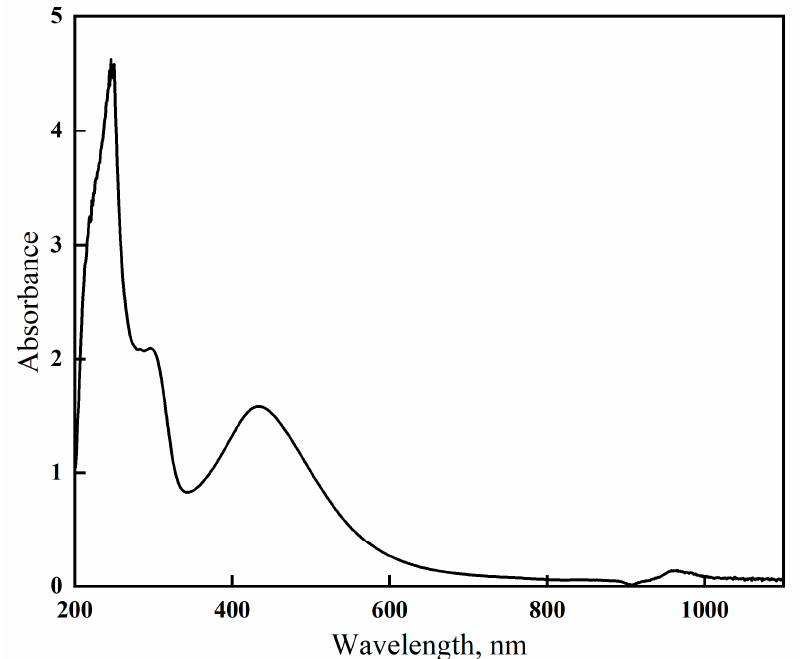
Figure 2. Wavelength of AgNPs produced after gelatin-silver reagent (1:3) react with maltose. Conditions: A 1 mL of the reaction mixture contained 250 µL maltose (0.1 mM), 250 µL Tris–HNO 3 buffer PH (0.2 M), 500 µL gelatin-silver reagent (1:3), incubated for 10 min at 90 °C.